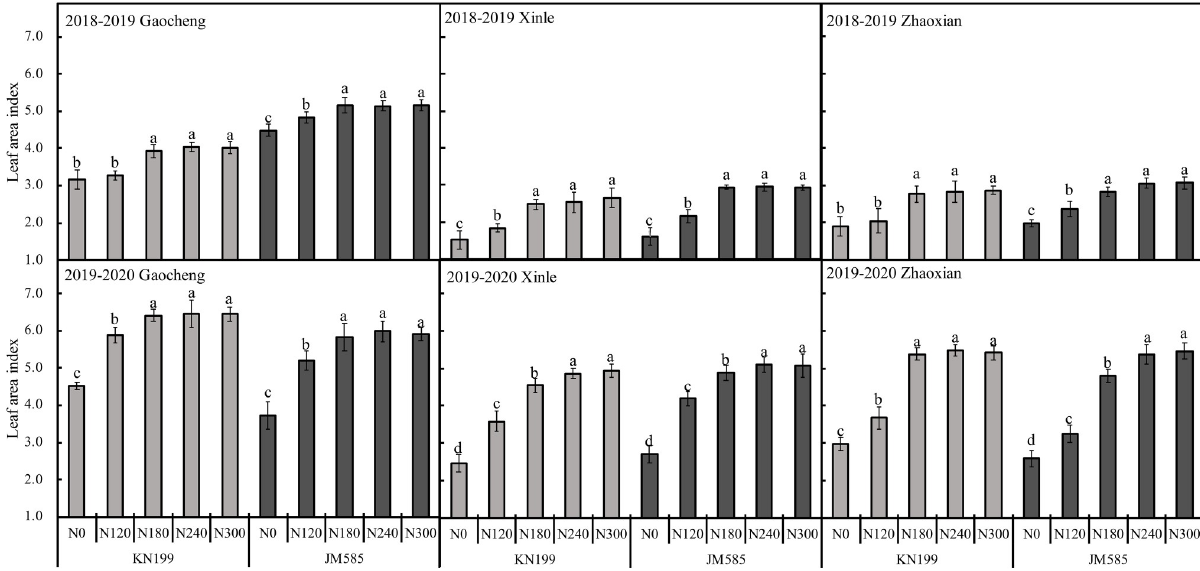
Fig 2. Leaf area index at anthesis of different winter wheat varieties under different nitrogen fertilization rates in three experimental sites during 2018–2020 seasons. Error bars represent one standard deviation from the mean. Letters above the bars are comparison results of leaf area index between different nitrogen treatments of the same variety. There is no significant difference between treatments with same letters.